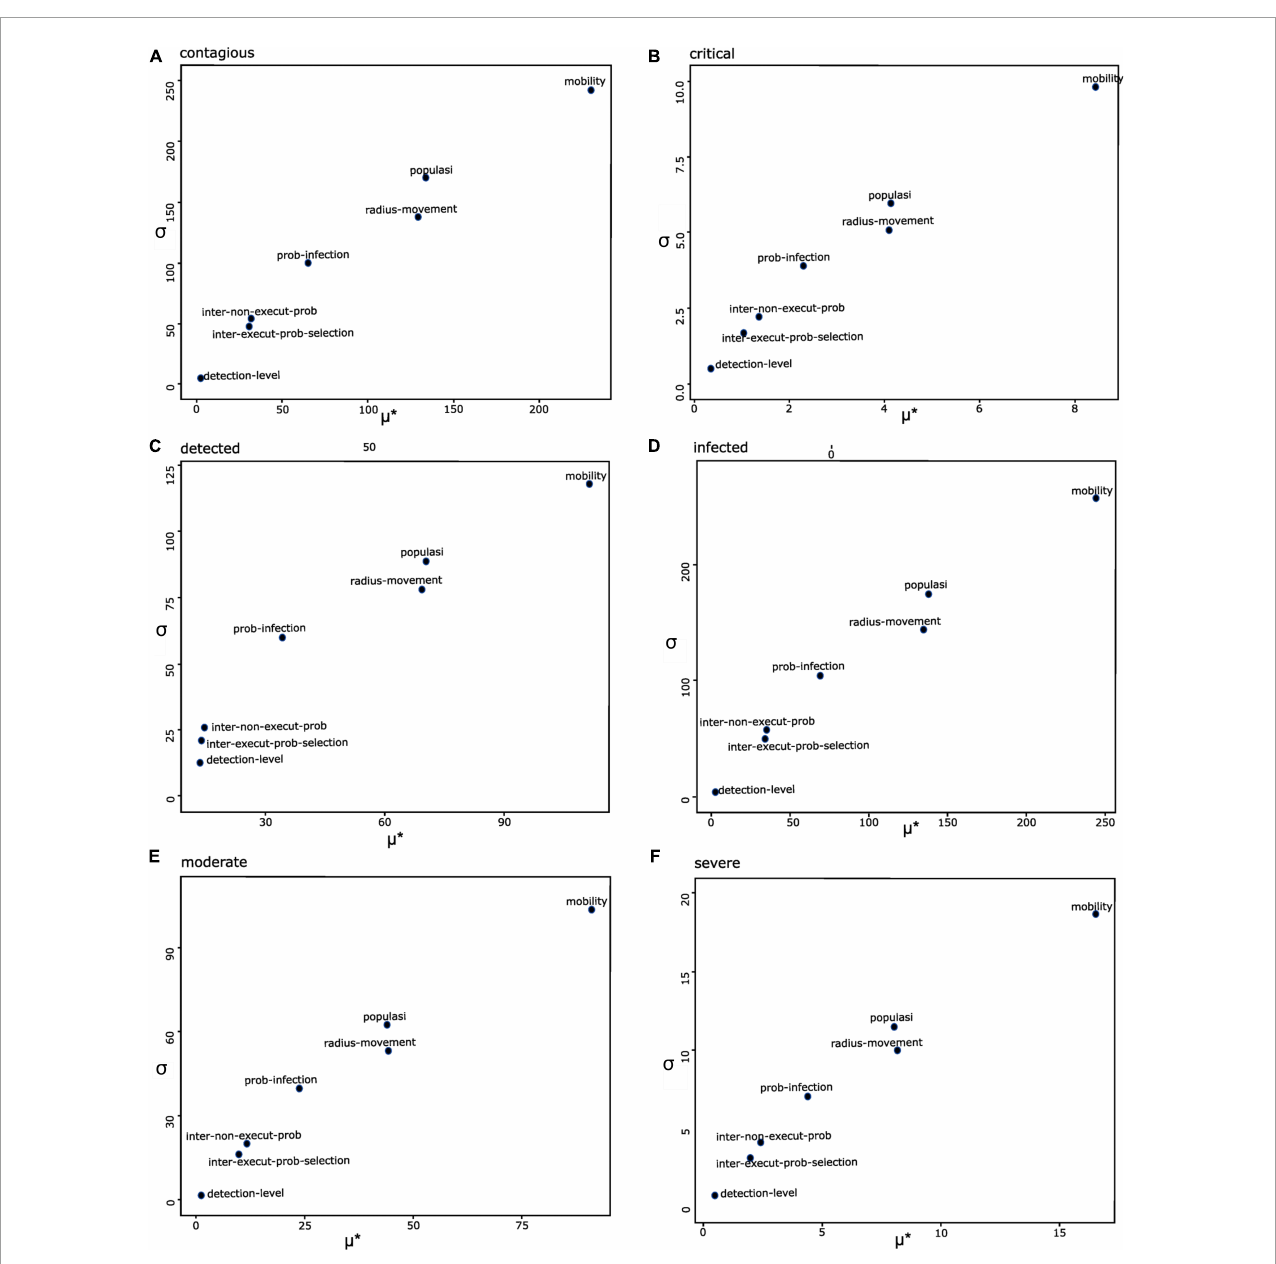
FIGURE4 Sensitivity analysis uses the SAMPAN model’s main parameters to investigate their effect on the number of individuals with (A) contagious, (B) critical, (C) detected, (D) infected, (E) moderate, and (F) severe. The µ * represents the effect of a parameter on the model output. The σ shows the interaction of a parameter on the model